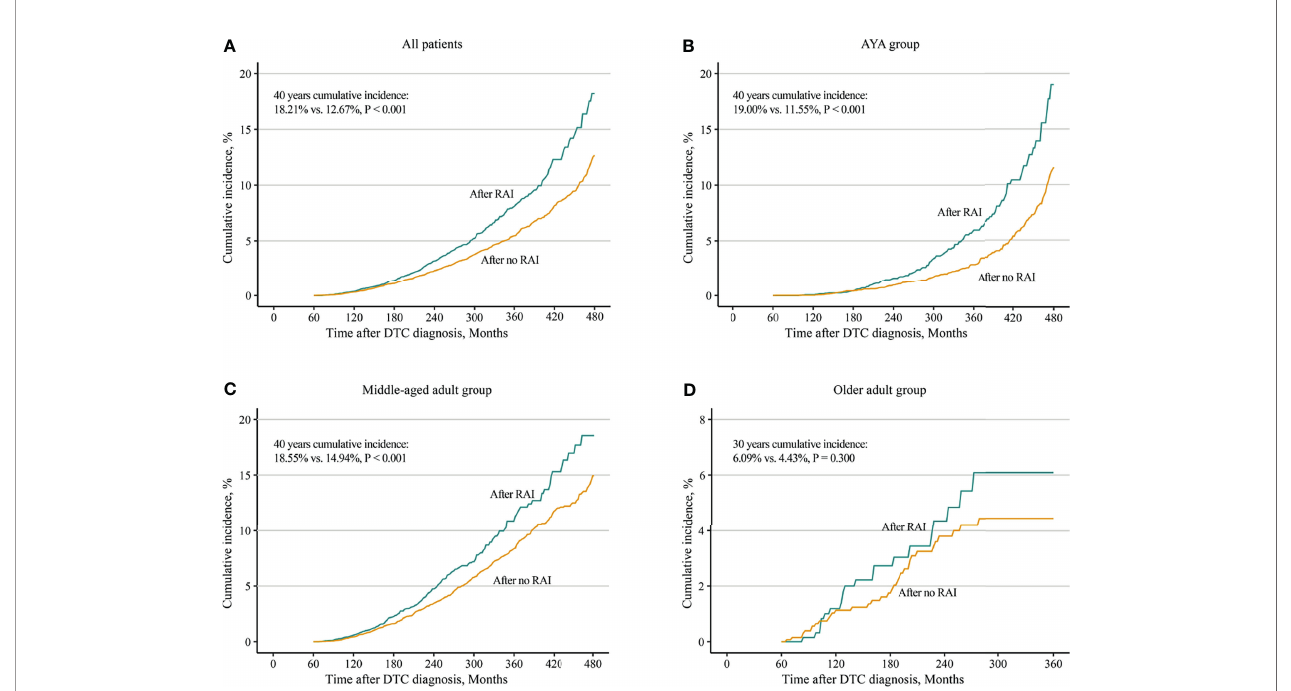
FIGURE 1 | Comparisons of cumulative incidences of second breast cancer in female differentiated thyroid cancer patients with radioiodine and with no radioiodine. (A) All patients, (B) AYA group, (C) middle-aged adult group, and (D) older adult group. RAI, radioiodine; DTC, differentiated thyroid cancer; AYA, adolescent and young adult.